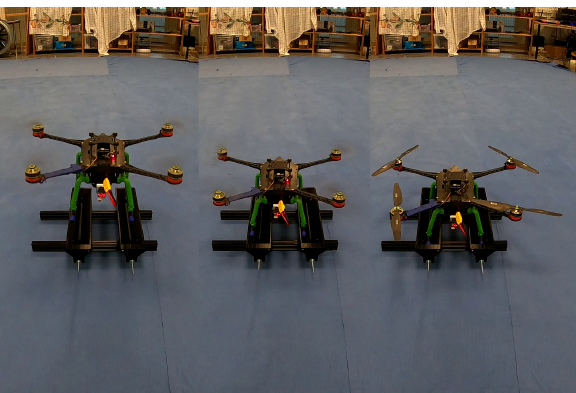
Figure 15. Landing and self-aligning of the drone on the platform.